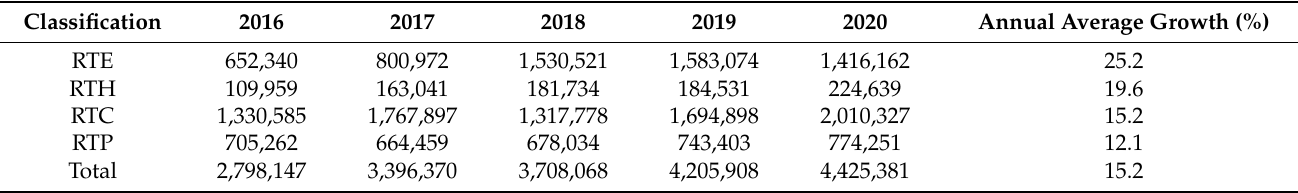
Table 2. Annual HMR sales in Korea (in